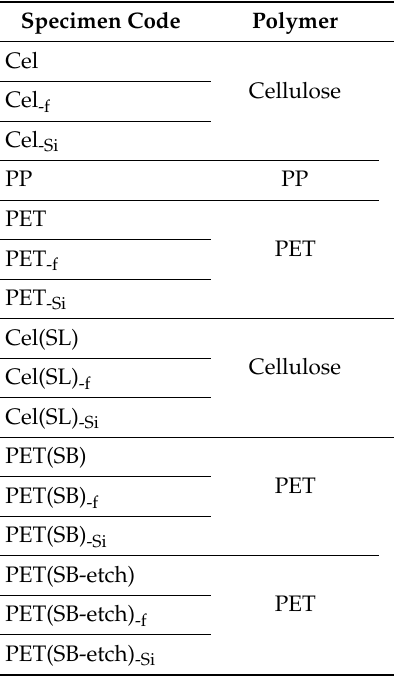
Table 2. Description of specimens.